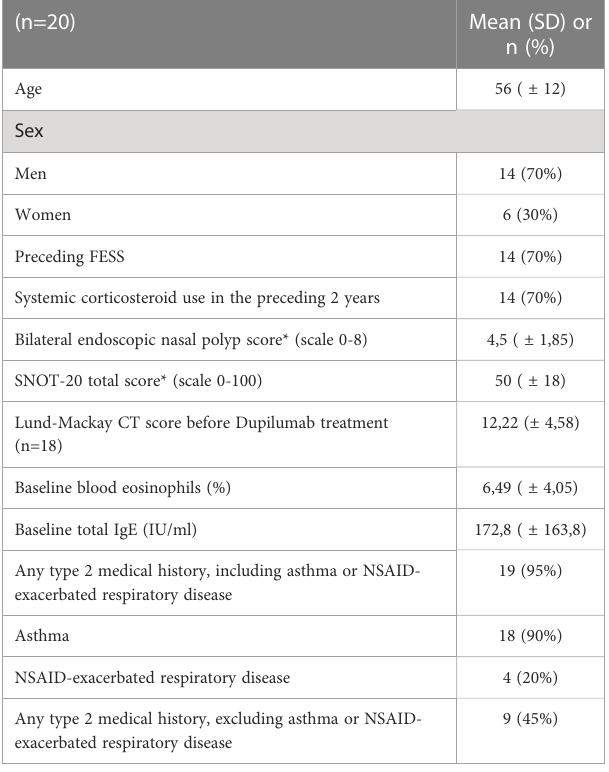
TABLE 1 Patient baseline demographics and clinical characteristics; SNOT-20, 20-item Sino-Nasal Outcome Test; NSAID, non-steroidal anti- in fl ammatory drug; *Higher scores indicate greater disease